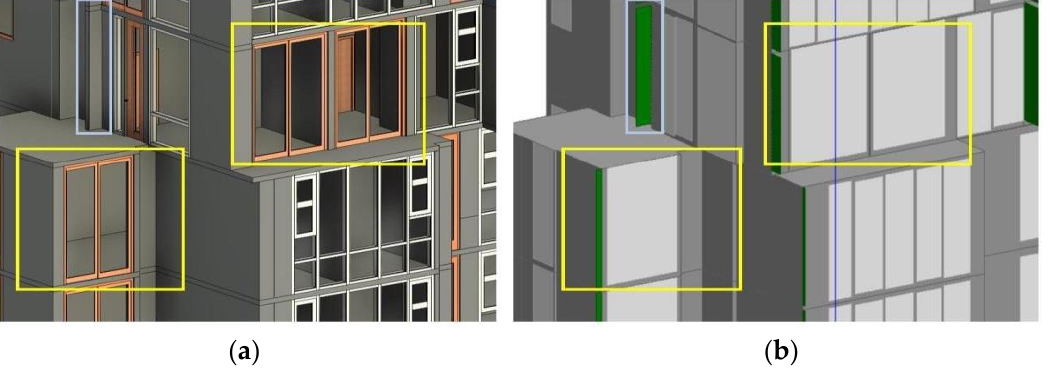
Figure 4. Comparison between elements in the original BIM model ( a ) and revised analytical model ( b ).